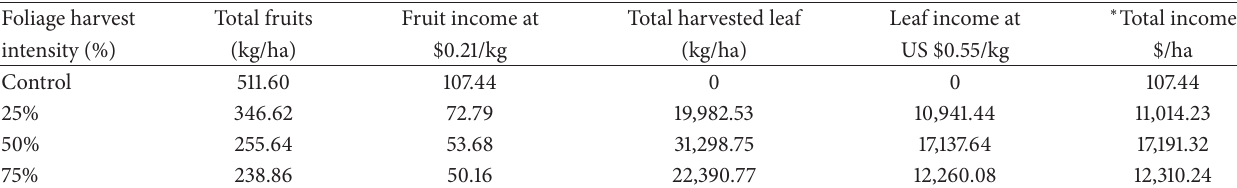
Table 1: An estimated income from fruit and leave harvest of T. daniellii stands over 64 weeks. Foliage harvest